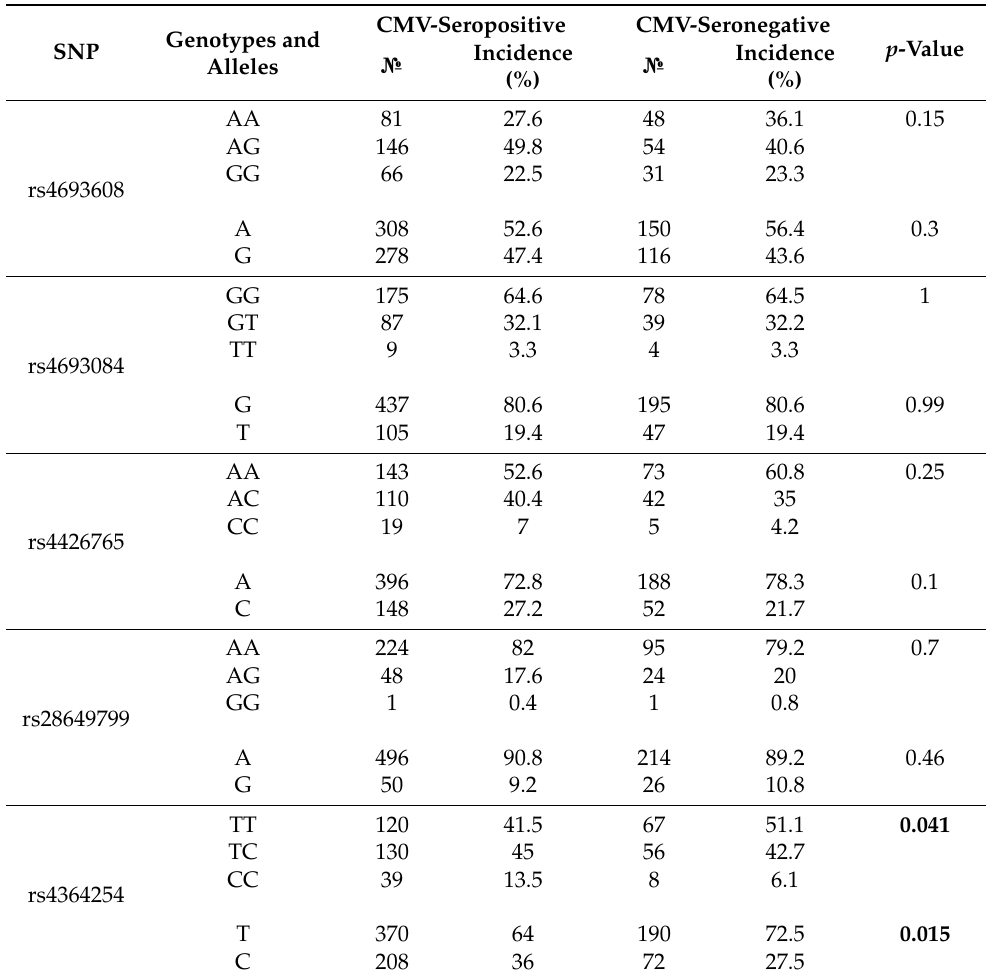
Table 1. Genotype and allele frequencies of the HPSE gene SNPs in CMV seropositive and seronega- tive healthy